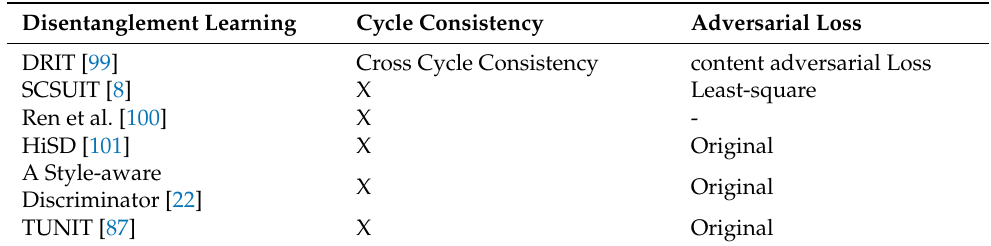
Table 9. Comparison between papers in the part disentanglement learning category (Section 9.1). In this table, we made the comparison based on if the cycle consistency is used and the type of adversarial loss used. “V” and “X” means that the method use the technique in the columns is “used” and “not used” respectively. “-” indicates that the corresponding information has not been found.